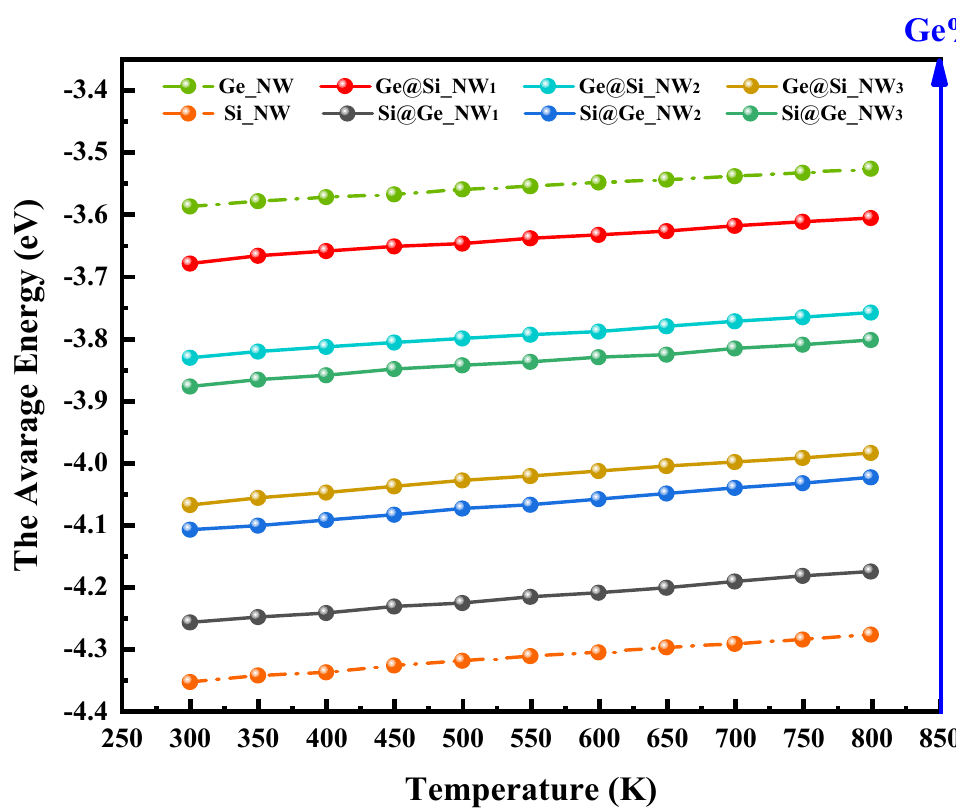
Figure 2. Variation of potential energy per atom for Ge@Si and Si@Ge nanowires with different core–shell ratios.